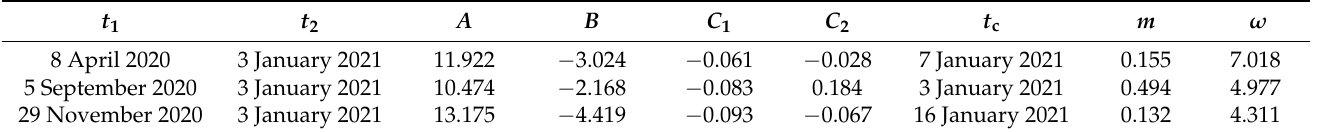
Figure 3. Three typical fitting examples with the same endpoint 𝑡 (cid:2870) = January 3, 2021, and three different sets of starting time: 𝑡 (cid:2869) = April 8, 2020, 𝑡 (cid:2869) = September 5, 2020, and 𝑡 (cid:2869) = November 29, 2020—corresponding to the long, middle, and short time scale windows, respectively. Table 1. Samples of estimated parameters of the LPPLS model on the daily Bitcoin price.